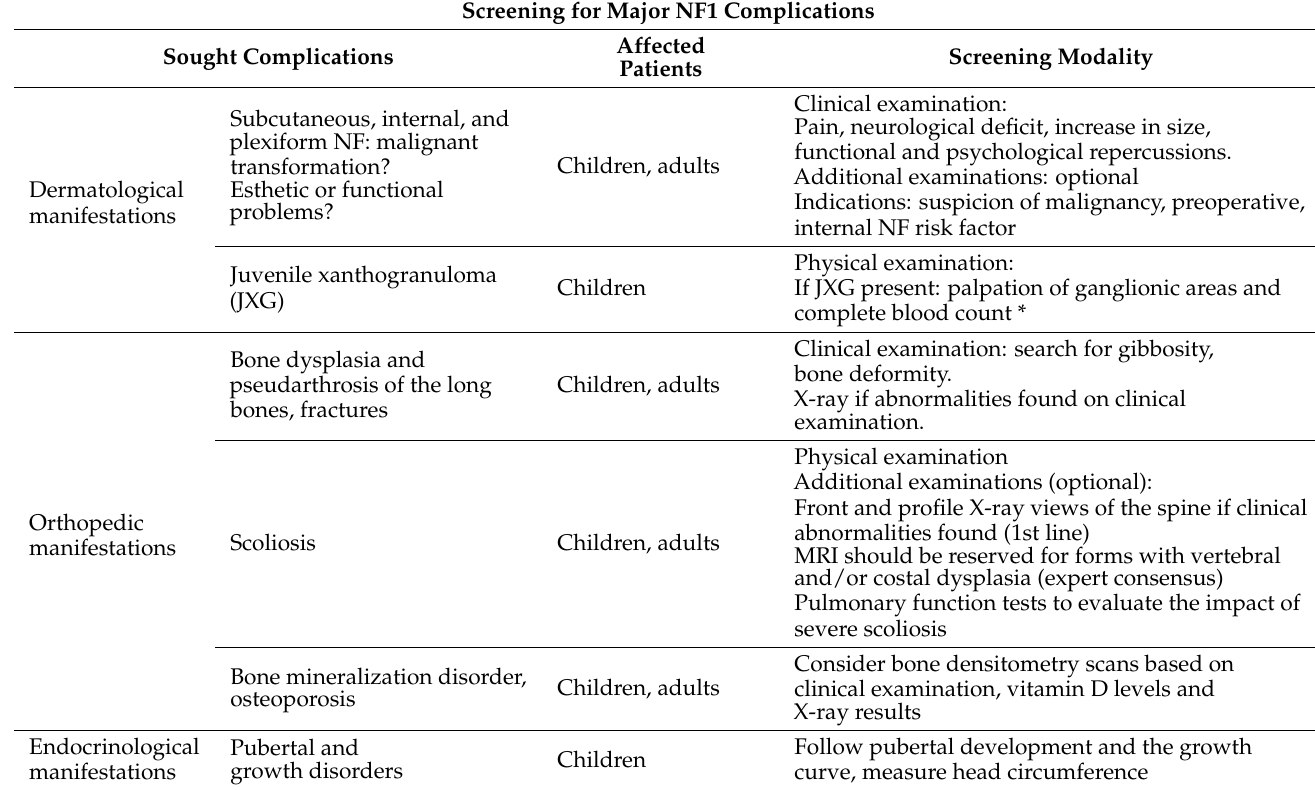
Table 3. Summary of screening procedures to be performed in the medical follow-up of patients with NF1, as recommended by the NF France network and reported by Bergqvist et al.